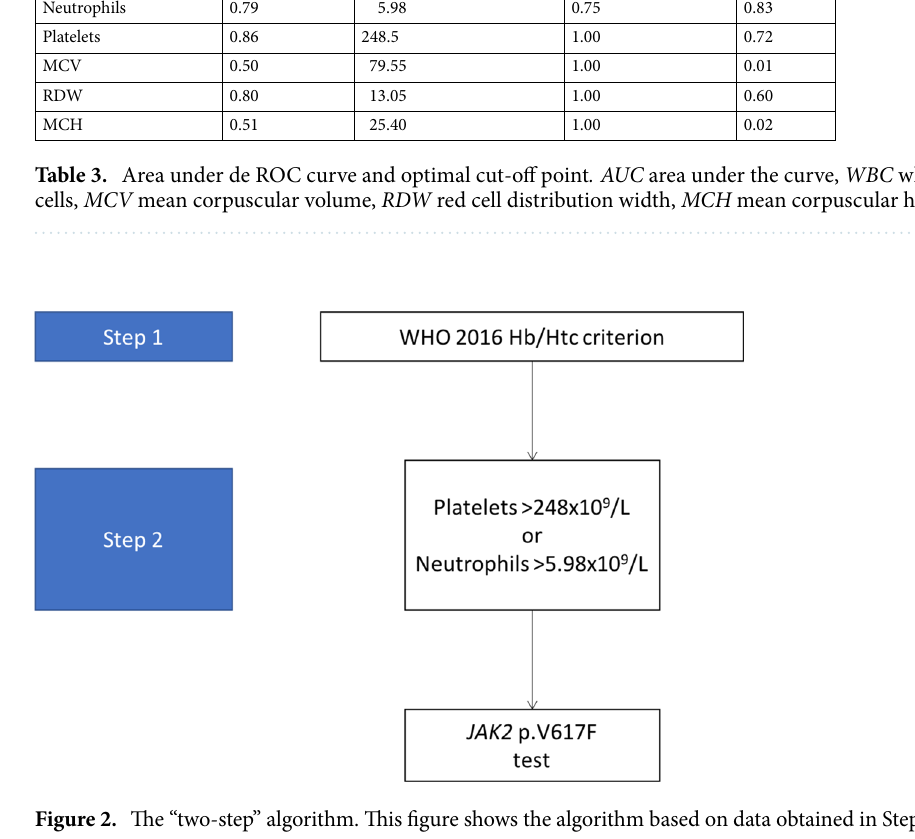
AUC Optimal cut-off Sensibility Specificity